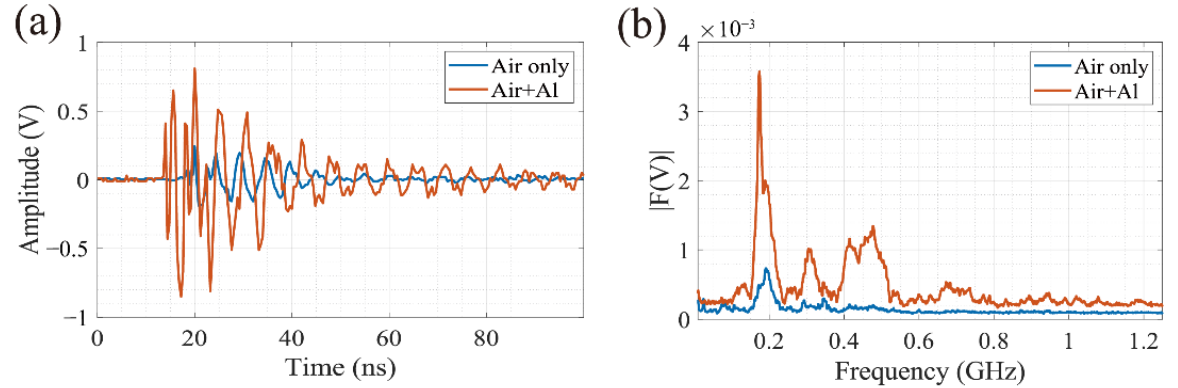
Figure 2. ( a ) Time domain EMP signals measured using the oscilloscope. ( b ) Frequency domain signals, obtained through numerical fast Fourier transform of the time-domain signal. The orange and blue curves correspond to the signals generated from the interaction between laser filament and the 3 mm-thick alloy target and from only the laser filament, respectively. The other experimental parameters were the same: laser energy = 850 mJ, laser pulse width = 30 fs, detection distance = 50 cm, and detection angle = 0°. The spectral and waveform amplitude measurements were averaged from 10 laser shots.